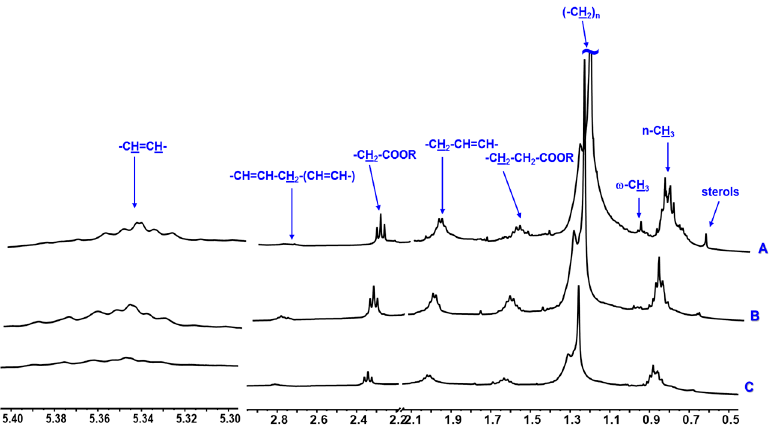
Figure 1. 1 H HR-MAS NMR spectra (400 MHz, CDCl 3 ) of the microalgae N. oceanica (A), C. muelleri (B), and C. weissflogii (C). In blue, types of hydrogens of polyunsaturated fatty acids are indicated.